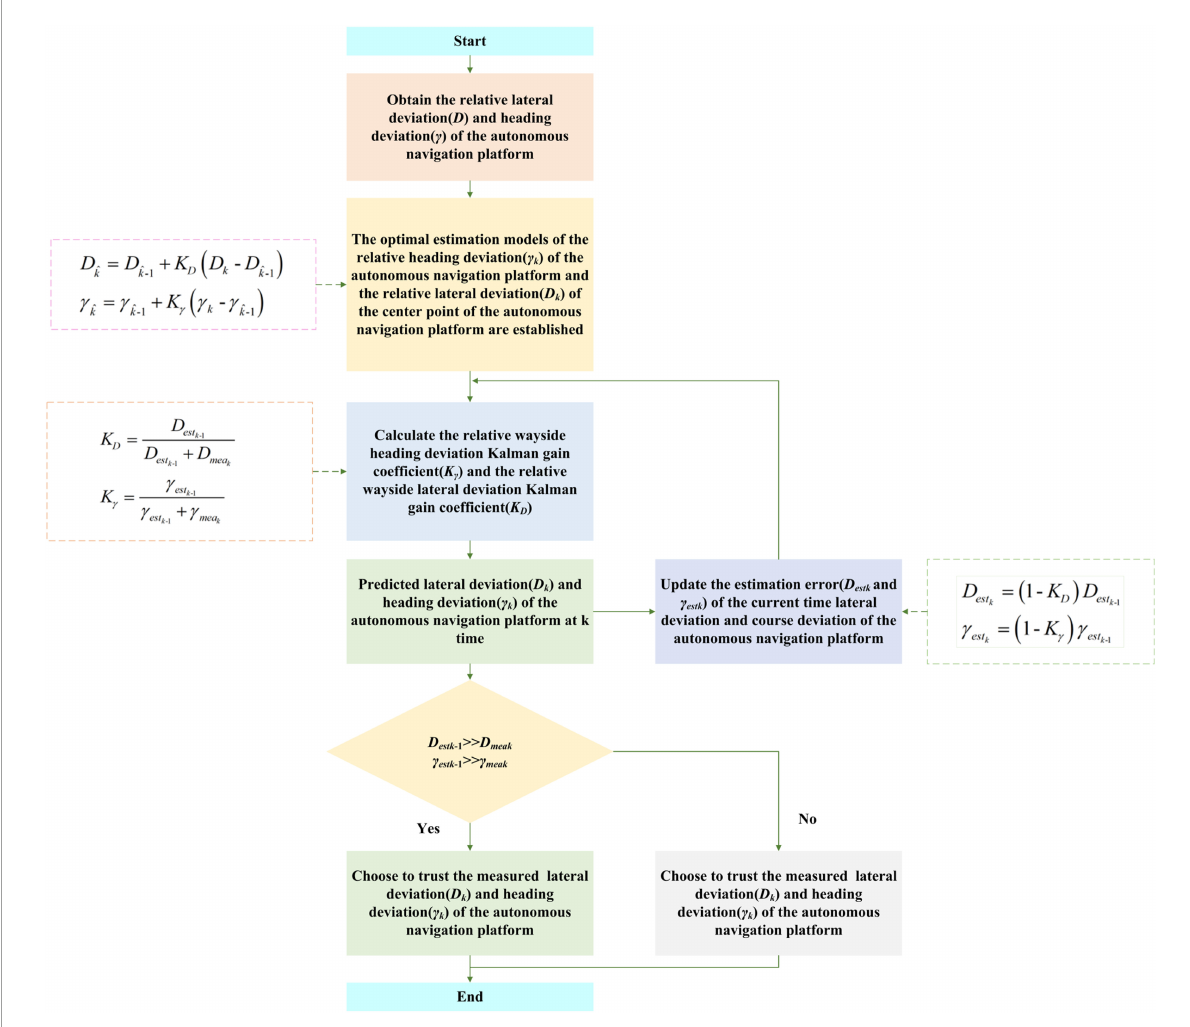
FIGURE18 Kalman filter optimal estimation flow of a relative wayside pose: D k . The observed lateral deviation of the current autonomous navigation platform relative to the road edge. D , the estimated lateral deviation of the current autonomous navigation platform relative to the road edge. b k D , estimated value of the lateral deviation of the autonomous navigation platform relative to the road edge at the last moment. K X , Kalman b k − 1 gain coefficient of relative lateral deviation of the autonomous navigation platform. γ k , the observed heading deviation of the current autonomous navigation platform relative to the road. γ , estimated heading deviation of the current autonomous navigation platform relative to b k the road edge. γ , estimated value of the heading deviation of the autonomous navigation platform relative to the road edge at the last time. b k − 1 K, Kalman gain coefficient of relative heading deviation of the autonomous navigation platform. D estk − 1 , the estimation error of the lateral deviation of the autonomous navigation platform relative to the road edge at the last moment. D meak , the current autonomous navigation platform-relative lateral deviation measurement error along the road. γ estk − 1 , the estimation error of the heading deviation of the autonomous navigation platform relative to the road at the last moment. γ meak , the current autonomous navigation platform relative along the road heading deviation measurement error. D estk , estimation error of lateral deviation of the autonomous navigation platform relative to the road edge at the current time. γ estk , the estimated error of the relative heading deviation of the autonomous navigation platform at the current